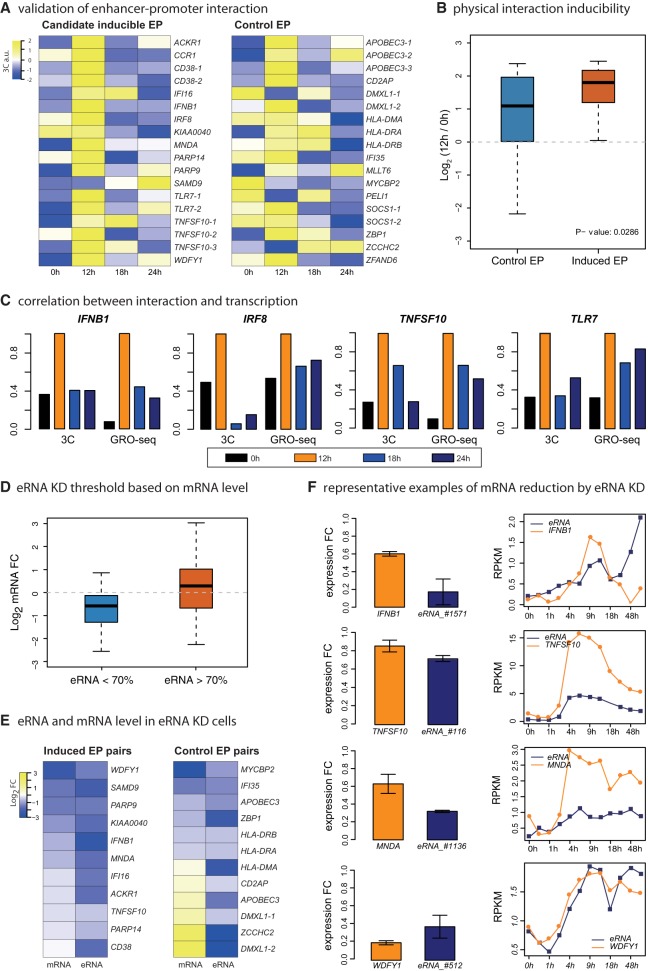
Effects of eRNA KD on target genes. (A) Heat maps of 3C signals for 18 inducible EP pairs and 18 control EP pairs within 200 kb are shown. Signals are normalized by BAC 3C interaction frequency. (B) Box plot of 3C log fold changes is shown (12 h vs. 0 h) for control and induced EP pairs with P-values from Kolmogorov–Smirnov (KS) test. (C) Representative examples of 3C results are shown and compared with GRO-seq signal (RPKM) of the corresponding immune-related genes. (D) Box plot shows mRNA fold changes for successful eRNA KD (eRNA < 70%) and unsuccessful eRNA KD (eRNA > 70%). (E) Heat map shows mRNA/eRNA log fold changes; 11 inducible EP pairs and 12 control pairs are included. (F) Representative examples of EP pairs where eRNA KD led to mRNA repression. mRNA/eRNA expression levels were measured by RT-qPCR. y-axes of expression curves represents GRO-seq signal (RPKM).